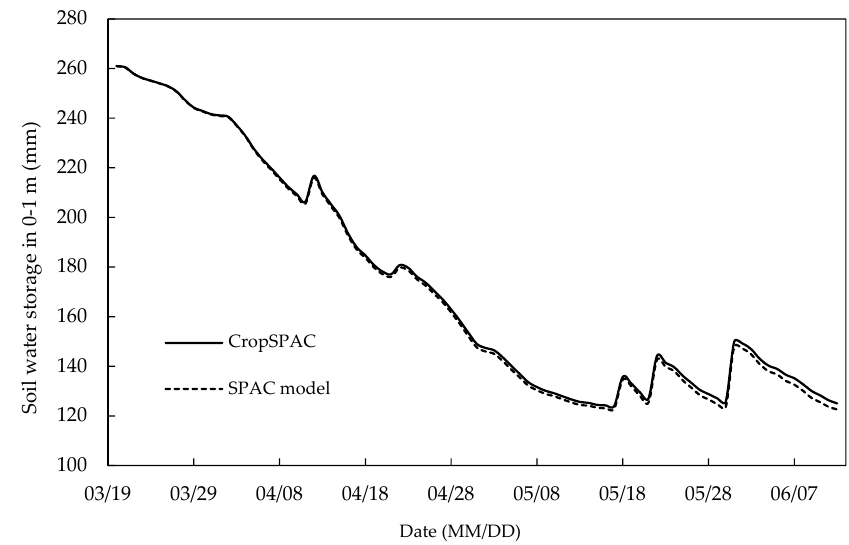
Figure 18. Comparison between CropSPAC and SPAC model simulated soil water storage in 0–1 m soil layer in W0 treatment.